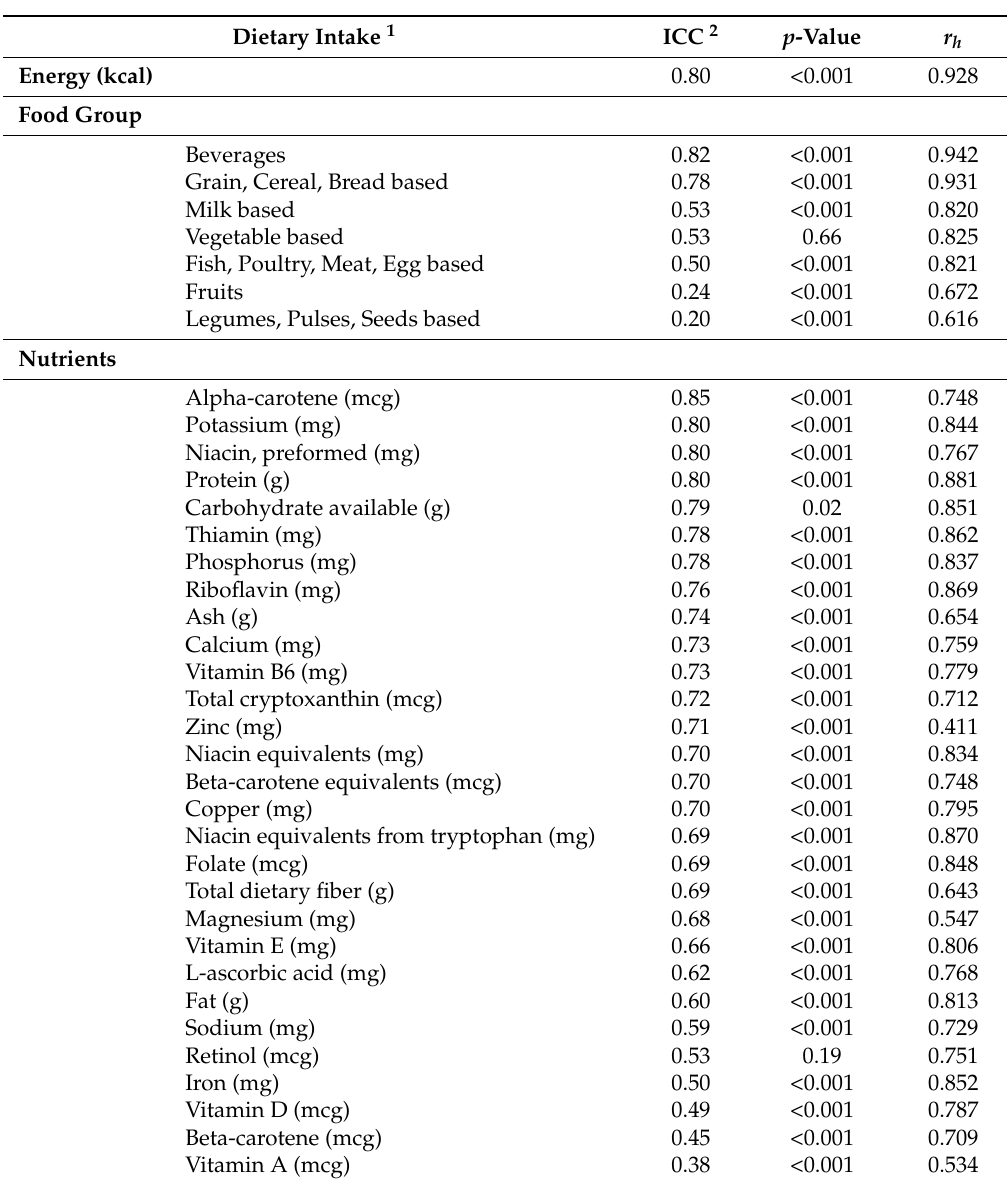
Table 2. Correlation of average daily food and nutrient intakes obtained from the two 3-day food diaries (FD) by the female head of the household, and the unobservable (hypothetical) correlation coefficient ( r h ) between observed intake (from FD) and true mean nutrient intakes of the population during the study period ( n =